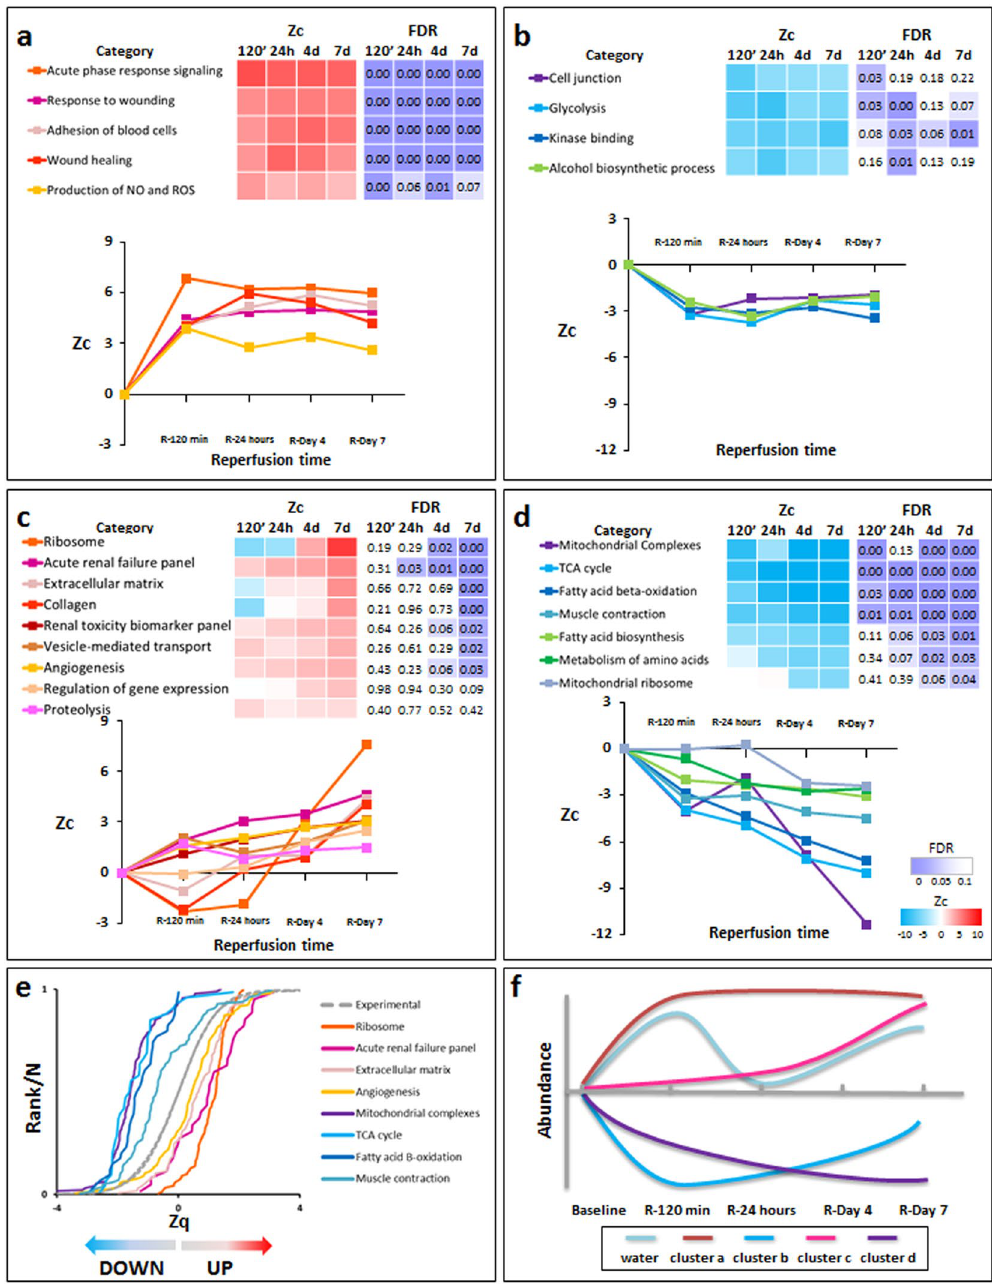
Figure 3. Quantitative proteomics time course analysis of early reperfusion after acute infarction in the ischemic myocardium. Quantitative proteomics screening approach results were analyzed using the Systems Biology Triangle (SBT) model to detect coordinated protein changes in functional categories over time. Functional categories significantly altered (False Discovery Rate, FDR < 0.05) at least one time point were classified into four clusters ( a – d ) Cluster a, increasing after 120 min with sustained upregulation for 7 days after ischemia onset; Cluster b, decreasing after 120 min and recovering to baseline values at day 7, except for glycolysis and kinase-binding proteins. Cluster c, increasing at days 4 and 7, with maximum change at day 7; and Cluster d, decreasing over time, with a tendency to reach minimum values at day 7. Protein values (Zq) and functional category values (Zc) are reported as log 2 fold changes with respect to baseline, in units of standard deviation. The complete set of proteins changing in each category is listed in Supplementary Tables S1–S4. Panel (e) displays the cumulative distributions of Zq from proteins belonging to a set of representative categories from clusters c and d , showing the high coordination of protein responses. ( f ) Schematic chart of changes in water content and protein clusters. The proteomics results presented here are representative of three technical replicate experiments using five animal sample